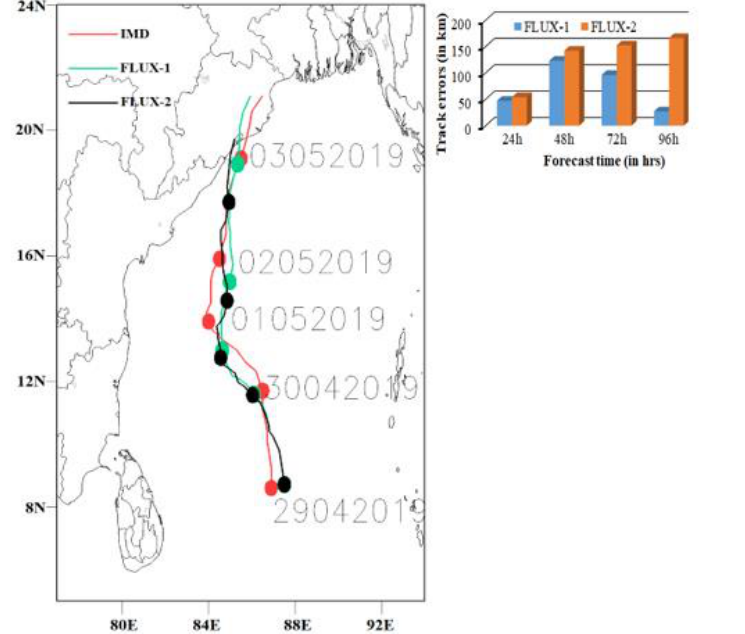
Figure 4 . Model simulated tracks from the FLUX-1 and FLUX-2 experiments along with IMD best-fit track at every 3 h interval (date is considered from IMD best fit-track), and track errors (in km) of both the experiments (The numeric in the figure indicates the date information in DDMMYYYY).